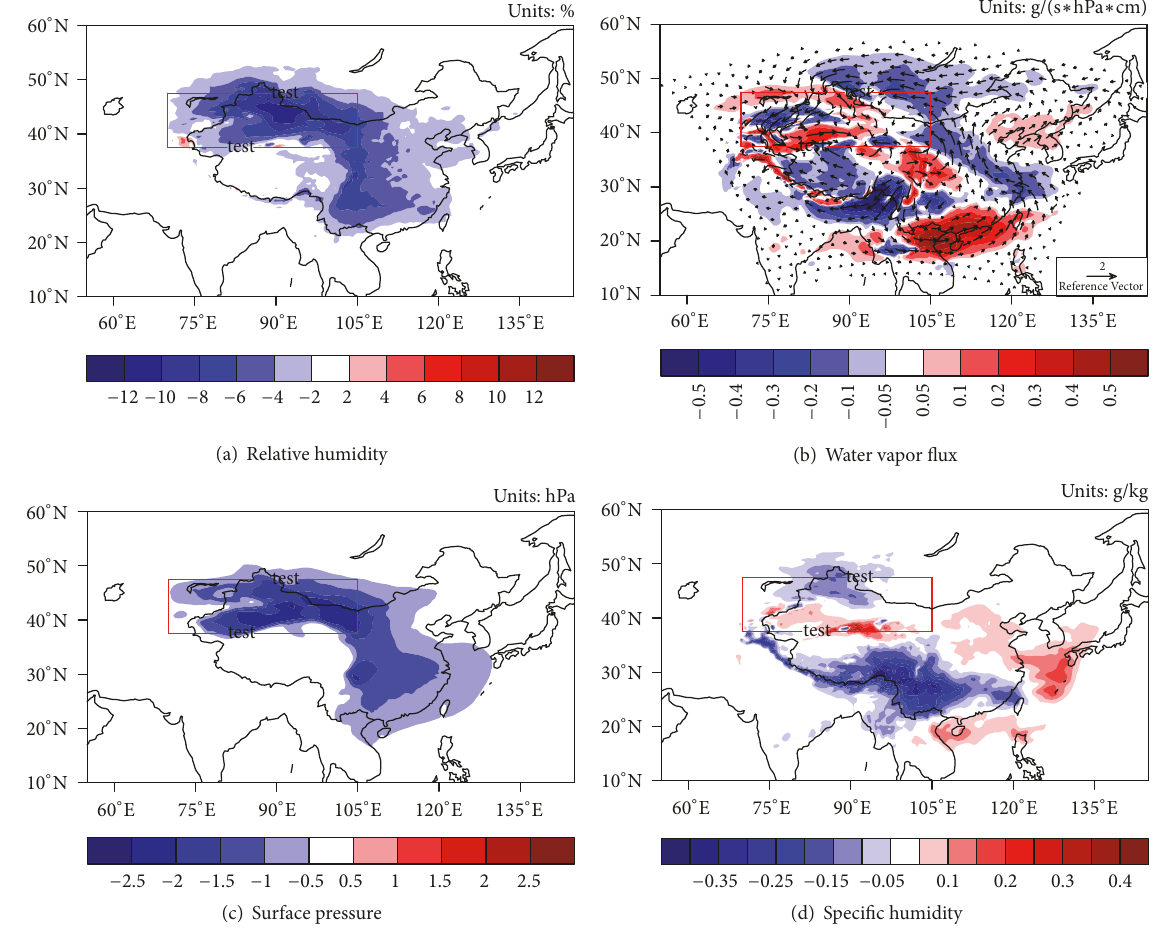
Figure 10: (a) The DIF (SE − CE) of 700 hPa relative humidity (%); (b) 700 hPa water vapor flux (g s −1 ⋅ hPa −1 ⋅ cm −1 ); (c) surface pressure (hPa); and (d) 700 hPa specific humidity (gkg −1 ) in April averaged from 2001 to 2010.